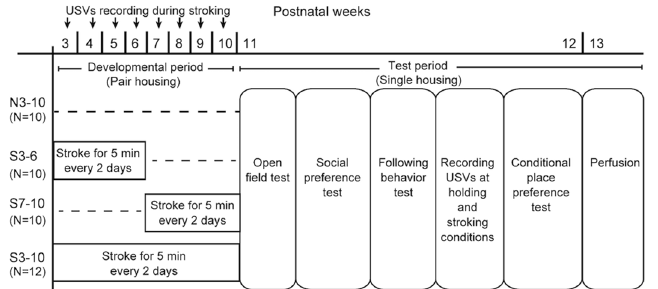
Figure 1. Time schedules of experiments. Ultrasonic vocalizations were recorded 5 min once per week between 3 and 10 weeks of age (developmental period) in the S3-6, S7-10, S3-10 groups. Behavioral tests were subsequently conducted in succession at the ages of 11 and 12 weeks (test